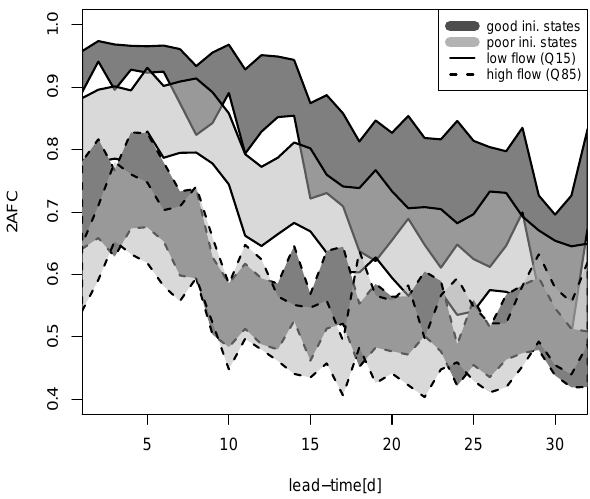
Fig. 5. 2AFC scores of probabilistic VarEPS/PREVAH daily runoff forecasts for different lead time ranges, different exceedance thresh- olds and different initial states qualities. The polygons show the 90% confidence interval, found by resampling 1000